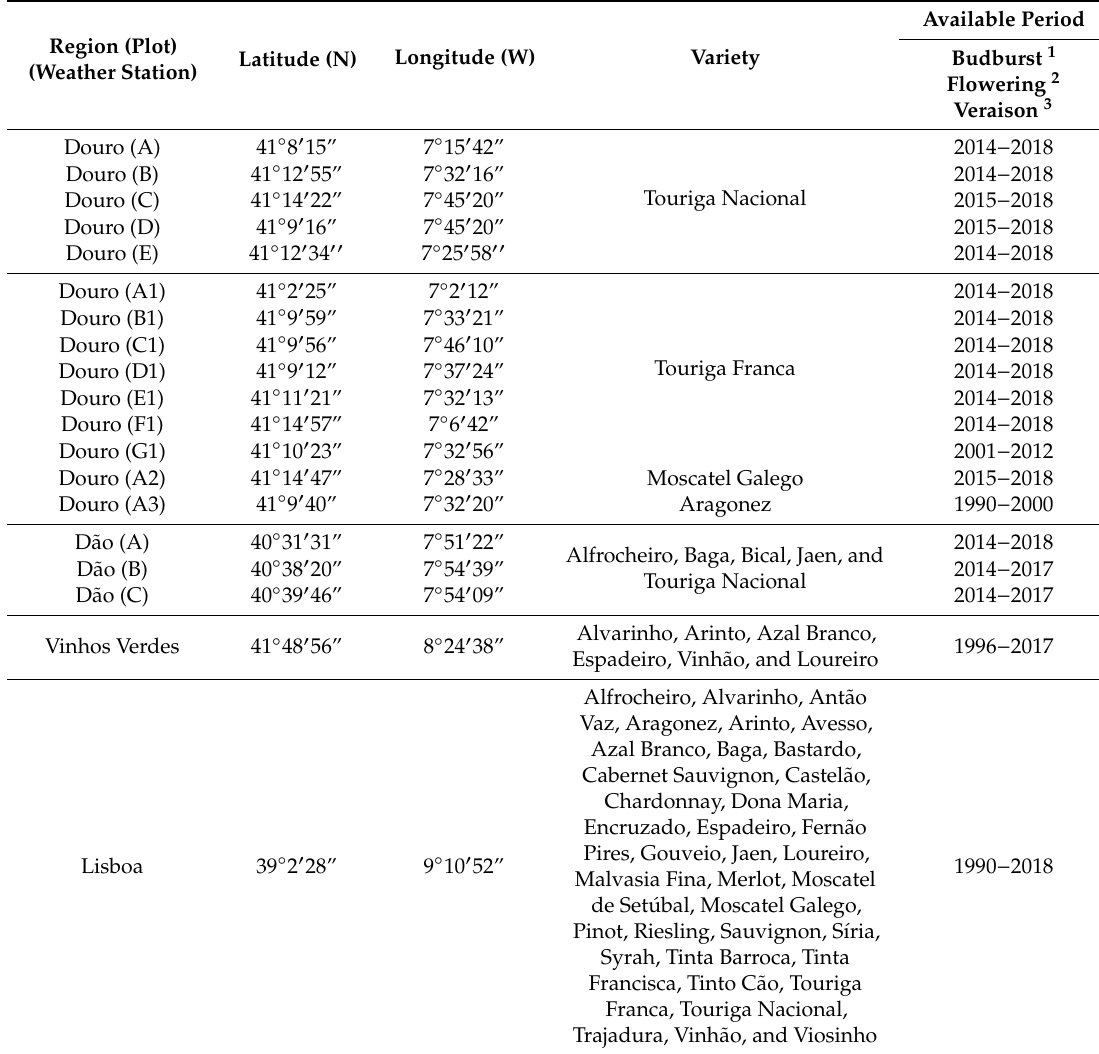
Table 1. Description of the selected phenological data for the three main phenological stages (budburst, flowering, and veraison) by wine region (Douro, D ã o, Vinhos Verdes, and Lisboa) and for the selected varieties. The geographical location (latitude and longitude) of each pair wine region / vineyard plot are indicated. The same locations apply to their corresponding weather stations. The grapevine varieties and the corresponding periods of phenological data are also